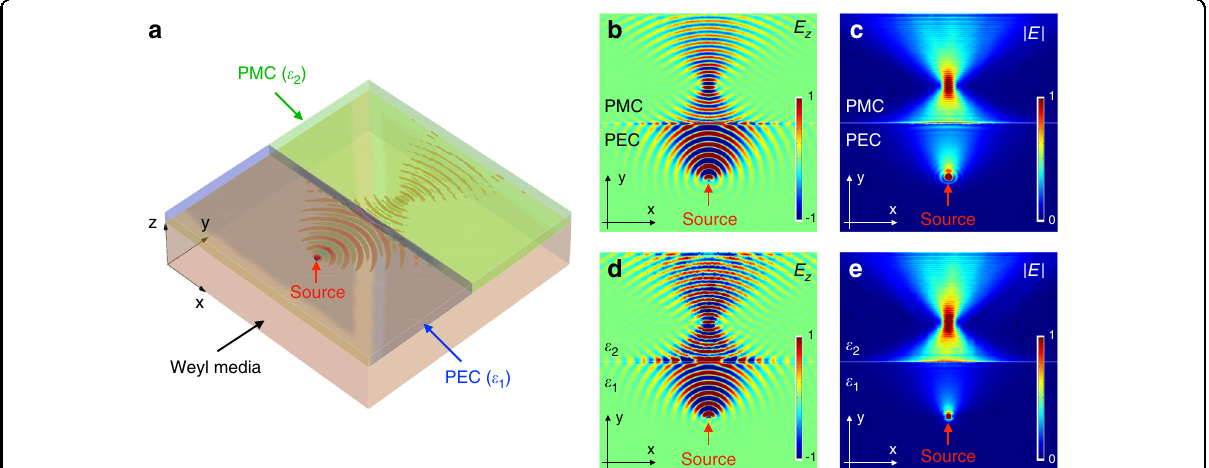
Fig. 4 Numerical con fi rmation of the all-angle re fl ectionless negative refraction (AREN). a Con fi guration for observing the AREN. Half of the top surface of the Weyl metamaterial is covered by a PEC layer, while the other half is covered by a PMC layer. A point source (electric dipole in z direction) is placed at the PEC/metamaterial interface. b , c Imaging due to the AREN. The distributions of electric fi eld Re ( E z ) and magnitude E j j at the frequency 25 GHz are plotted respectively. d , e The distribution of the electric fi eld and the magnitude obtained by replacing the PEC and PMC layers with two different dielectric layers ( ∈ 1 = − 10 and ∈ 2 = −